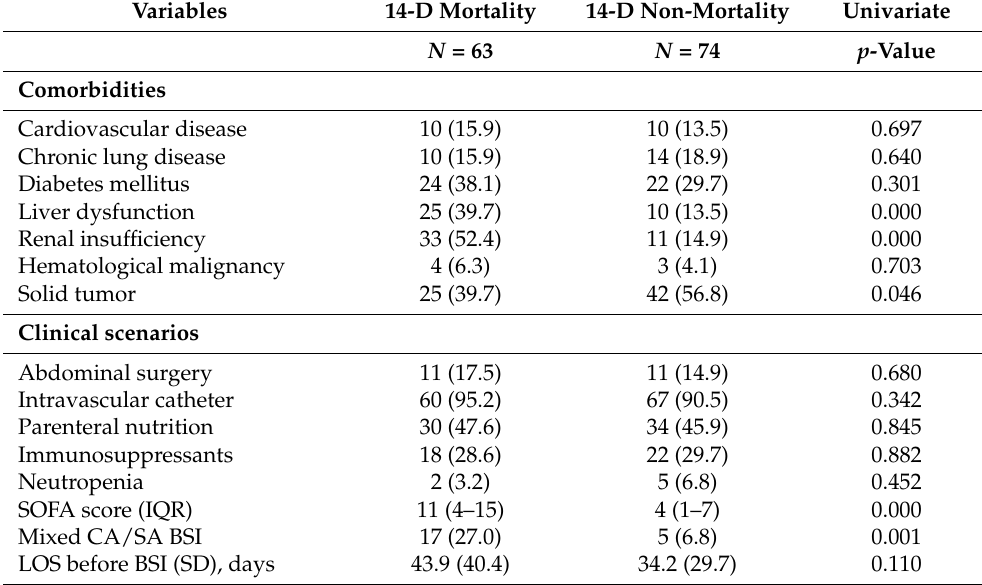
Table 2. A comparison of the variables for the 14-day survival and non-survival groups.